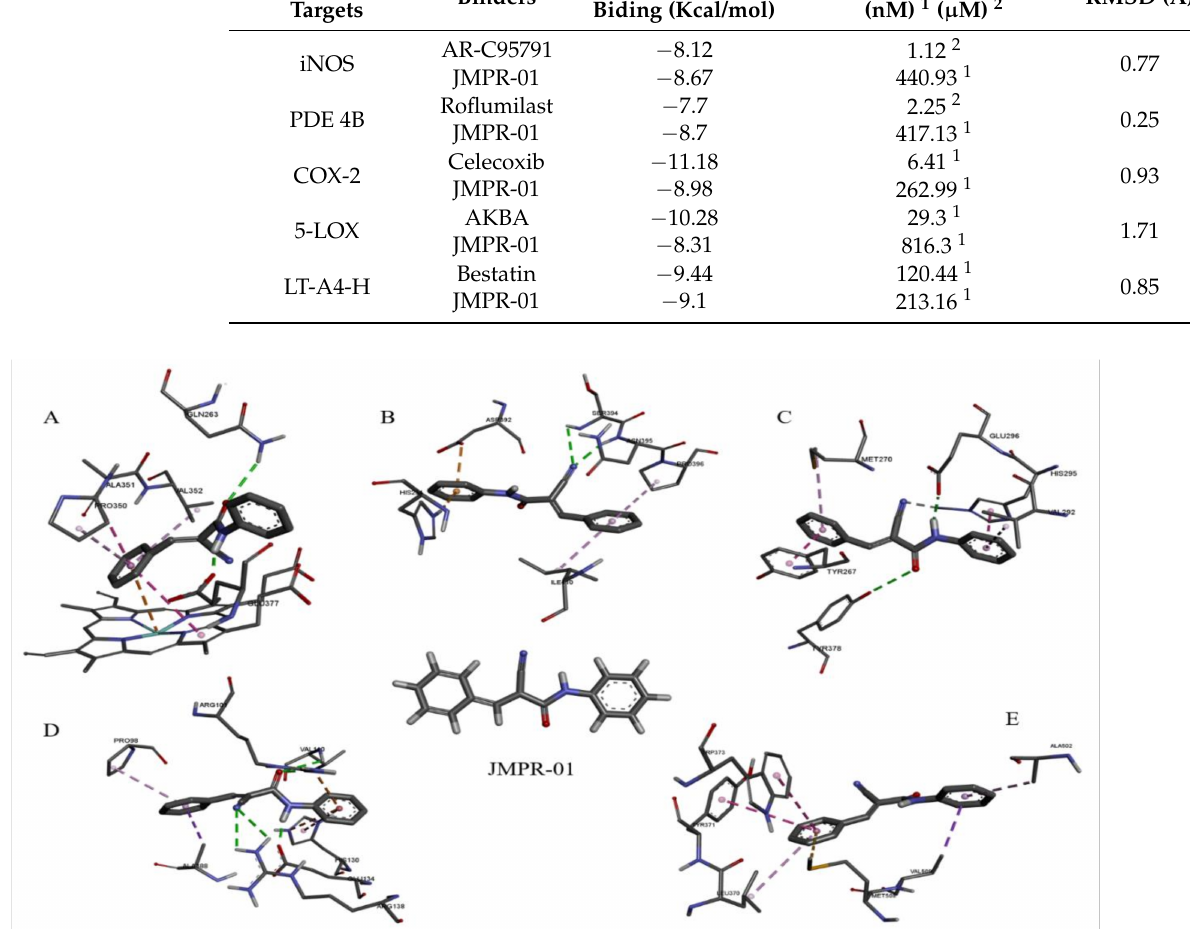
Figure 6. Representations of the poses assumed by JMPR-01 at the target binding site: ( A ) Inducible nitric oxide synthase (PDB ID: 3E7G), ( B ) Phosphodiesterase 4B (PDB ID: 1XMU), ( C ) Leukotriene A4 hydrolase (PDB ID: 1HS6), ( D ) 5-Lipoxygenase (PDB ID: 6NCF) and ( E ) Cyclooxygenase-2